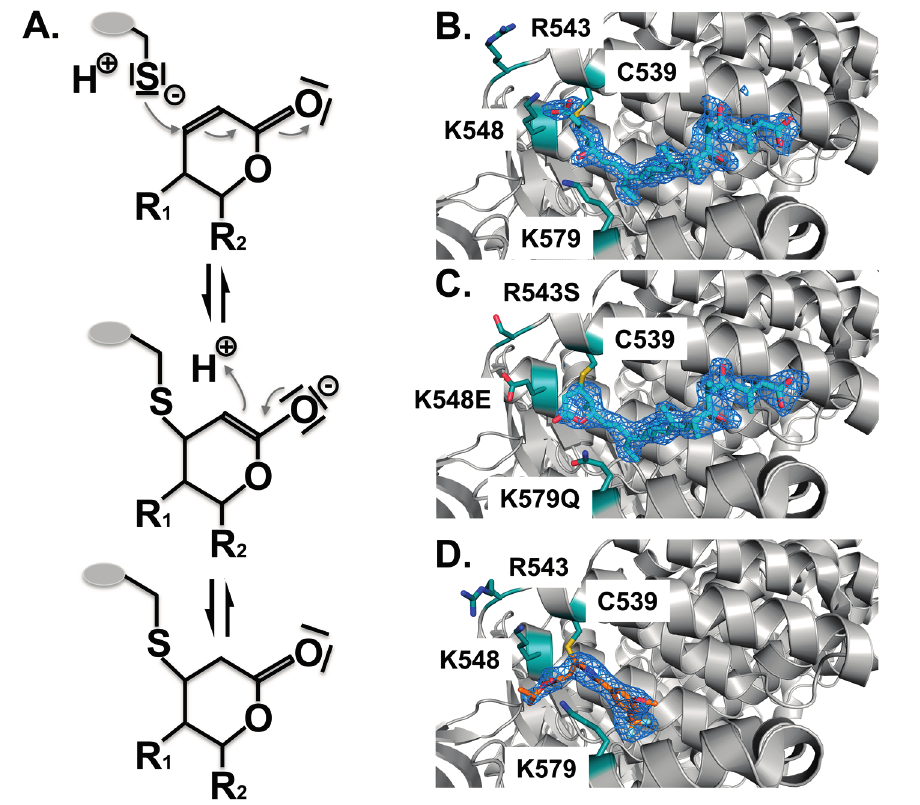
Figure 5. Covalent binding of inhibitors to the NES-binding cleft of CRM1. All